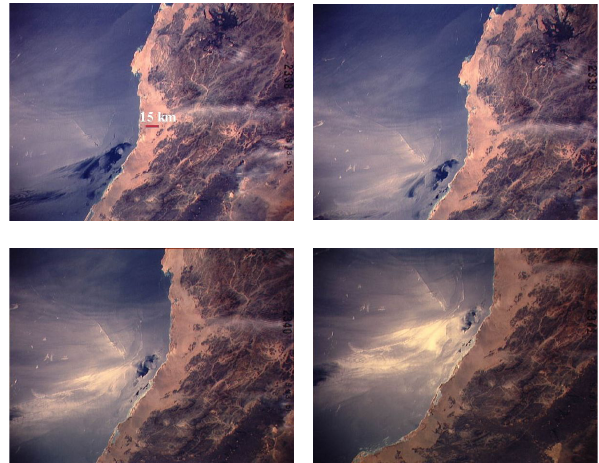
Fig. 4. Satellite images of transformation of internal waves at the shelf edge in the Red Sea. NASA images (23 ◦ N, 38 . 5 ◦ E; April 1984) from left to right and from upper to lower: STS41C-51-2338 (24 ◦ N, 38 ◦ E); STS41C-51-2339 (24 ◦ N, 38 ◦ E); STS41C-51-2340 (23 . 5 ◦ N, 38 . 5 ◦ E); STS41C-51-2341 (23 ◦ N, 38 . 5 ◦